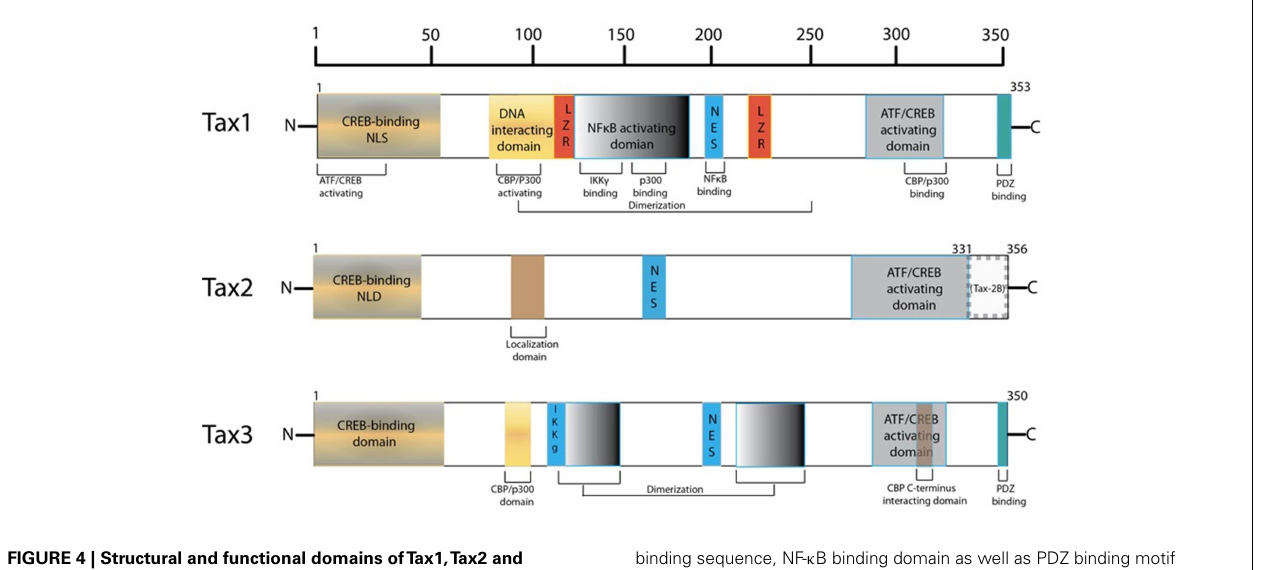
FIGURE 4 | Structural and functional domains ofTax1,Tax2 and Tax3. Specific domains, and the regions involved in transcriptional activation pathways are indicated. Nuclear Localization Signal (NLS), nuclear export signal (NES), leucin zipper region (LZR), CBP/p300